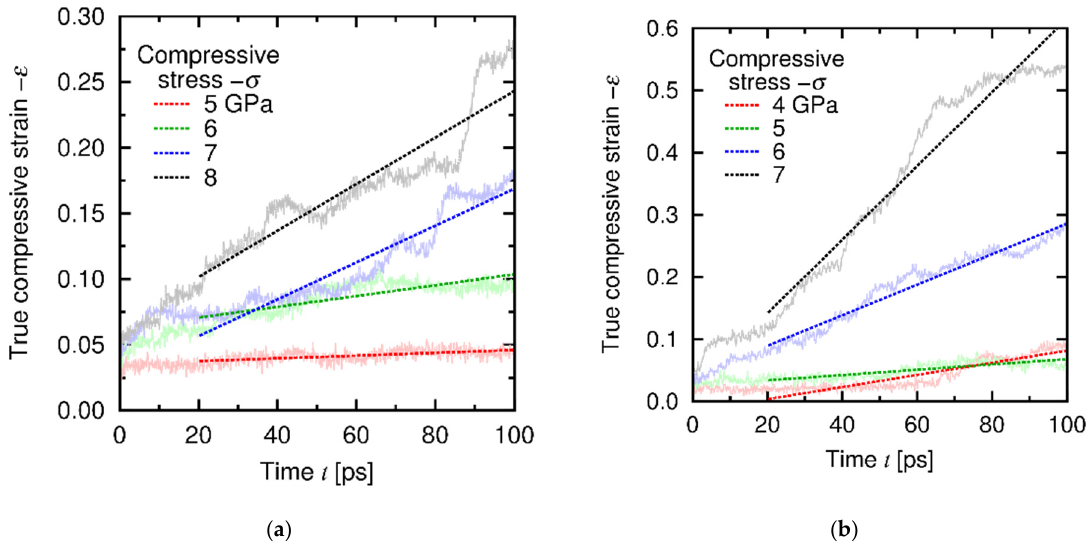
Figure 11. Temporal development of true compressive strain under the σ -constant conditions at ( a ) 1000 K and ( b ) 1500 K. The dashed lines indicate the linear approximations, and its slope is equal to the strain rate d ε / dt at the steady state.